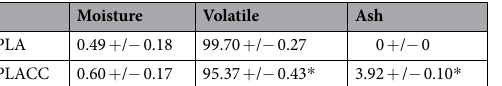
Table 1. The amount of moisture, volatile, and ash present in PLA and PLACC as determined by TGA. The symbol * indicates a significant difference between PLA and PLACC (n = 4).